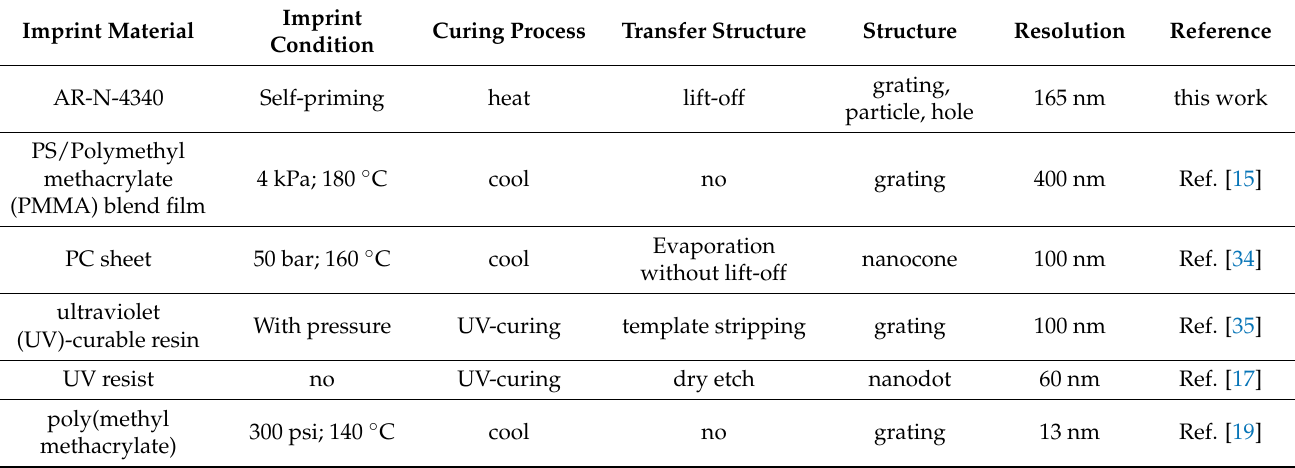
Figure 7. The SEM images during the process of fabricating the gold nanoparticle and nanohole arrays. ( a ) The SEM image of the photoresist after nanoimprinting for the first time. ( b ) The SEM image of silicon gratings after the etching of ( a ). ( c ) The SEM image of the photoresist after nanoimprinting on silicon gratings, rotated by 60°, for the second time. ( d ) The SEM image of the nanoparticle arrays on silicon after the etching of ( c ). Using the PDMS mold replicated from ( d ) to repeat the nanoimprinting process with a developing time of 210 s to obtain the nanoholes presented in ( e ), and with a developing time of 270 s to obtain the nanoparticles shown in ( g ). ( f ) The SEM image of gold nanoparticles after implementing gold evaporation and lift-off on ( e ). ( h ) The SEM image of gold nanoholes after implementing gold evaporation and lift-off on ( g ). Table 2. Comparison of self-priming nanoimprint with other nanoimprint